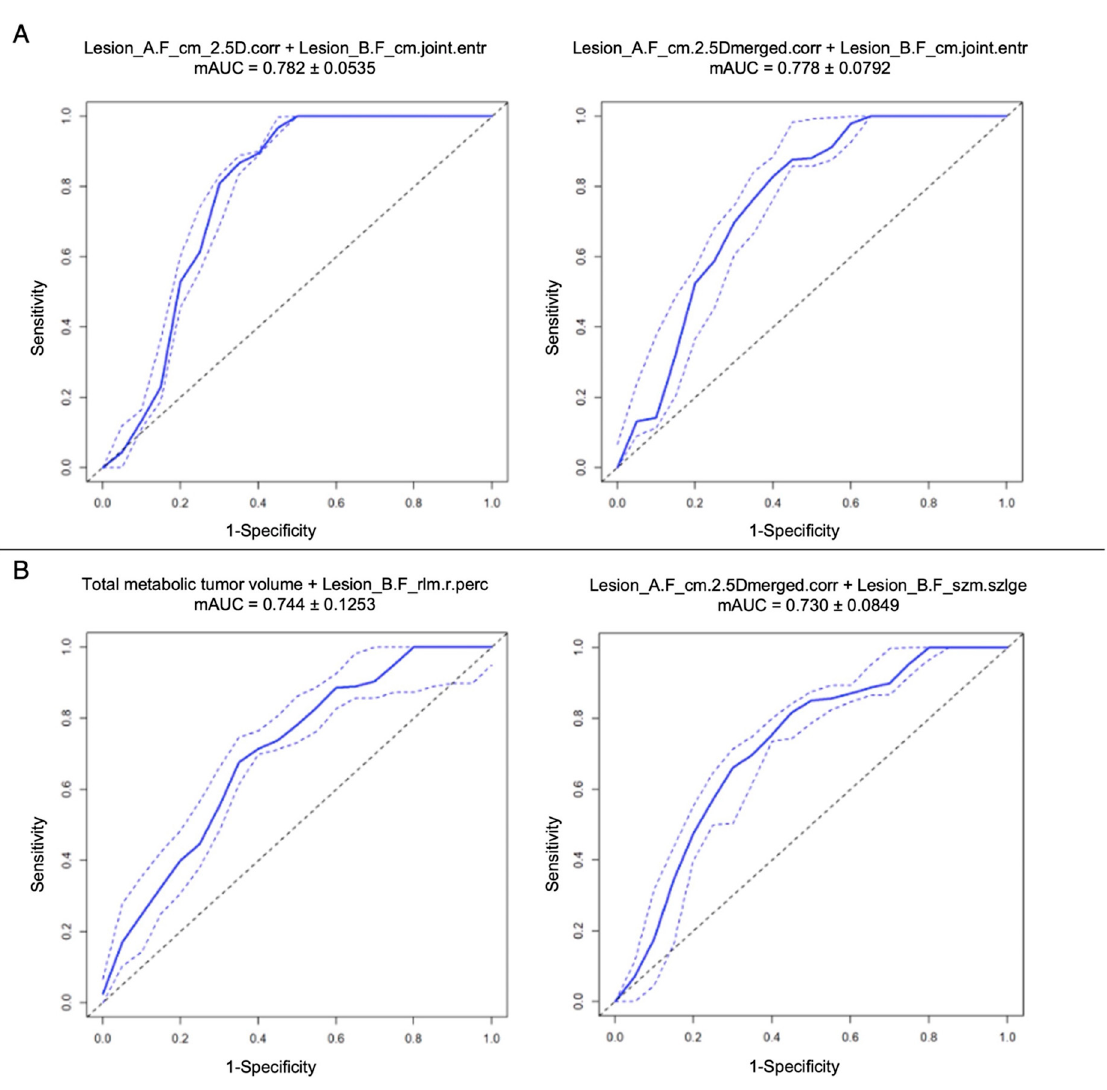
Figure 4. Anatomical site distribution of Lesion_A and Lesion_B among the entire cohort.